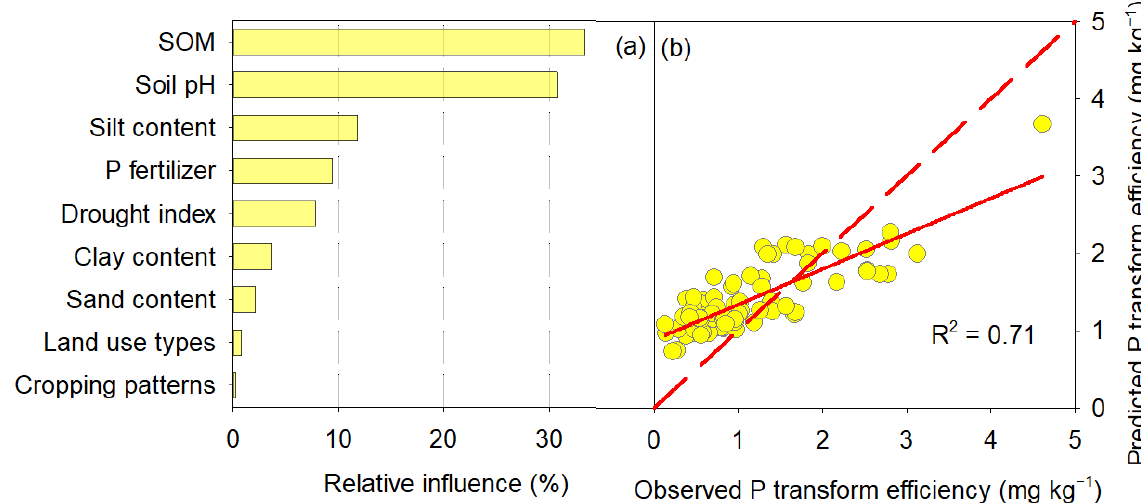
Figure 6. The relative contributions (%) of climate (drought index), soil properties (soil pH, SOM, and soil texture) and management practices (P fertilizer input, land use types, and cropping patterns) to SPTE, estimated by the boosted regression tree (BRT) model ( a ). The observed SPTE and those predicted by the boosted regression tree model using various predictors are shown in ( b ). The dotted line indicates the 1:1 line.